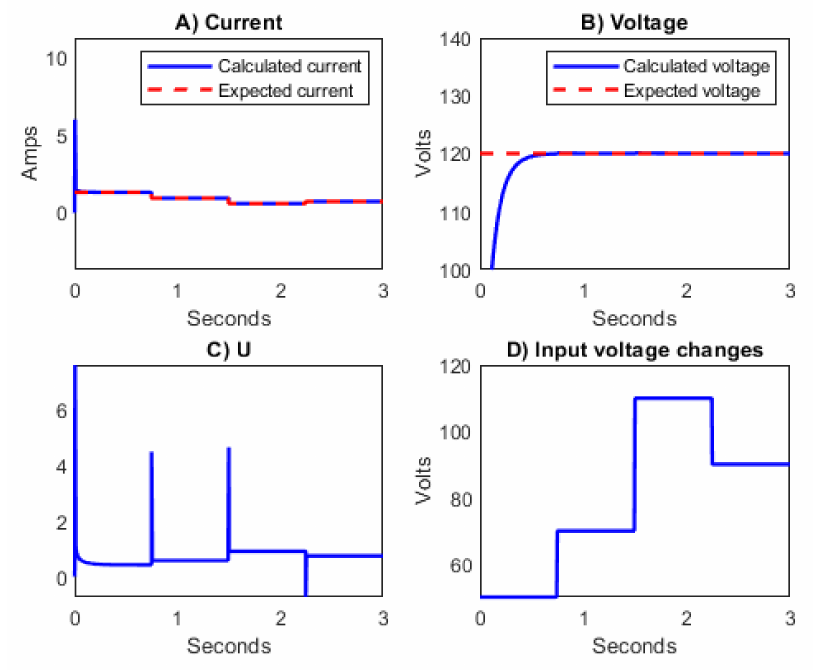
Figure 3. ( A ) Shows current behavior, (B ) boost converter output voltage, ( C ) duty cycle, and ( D ) input voltage changes.